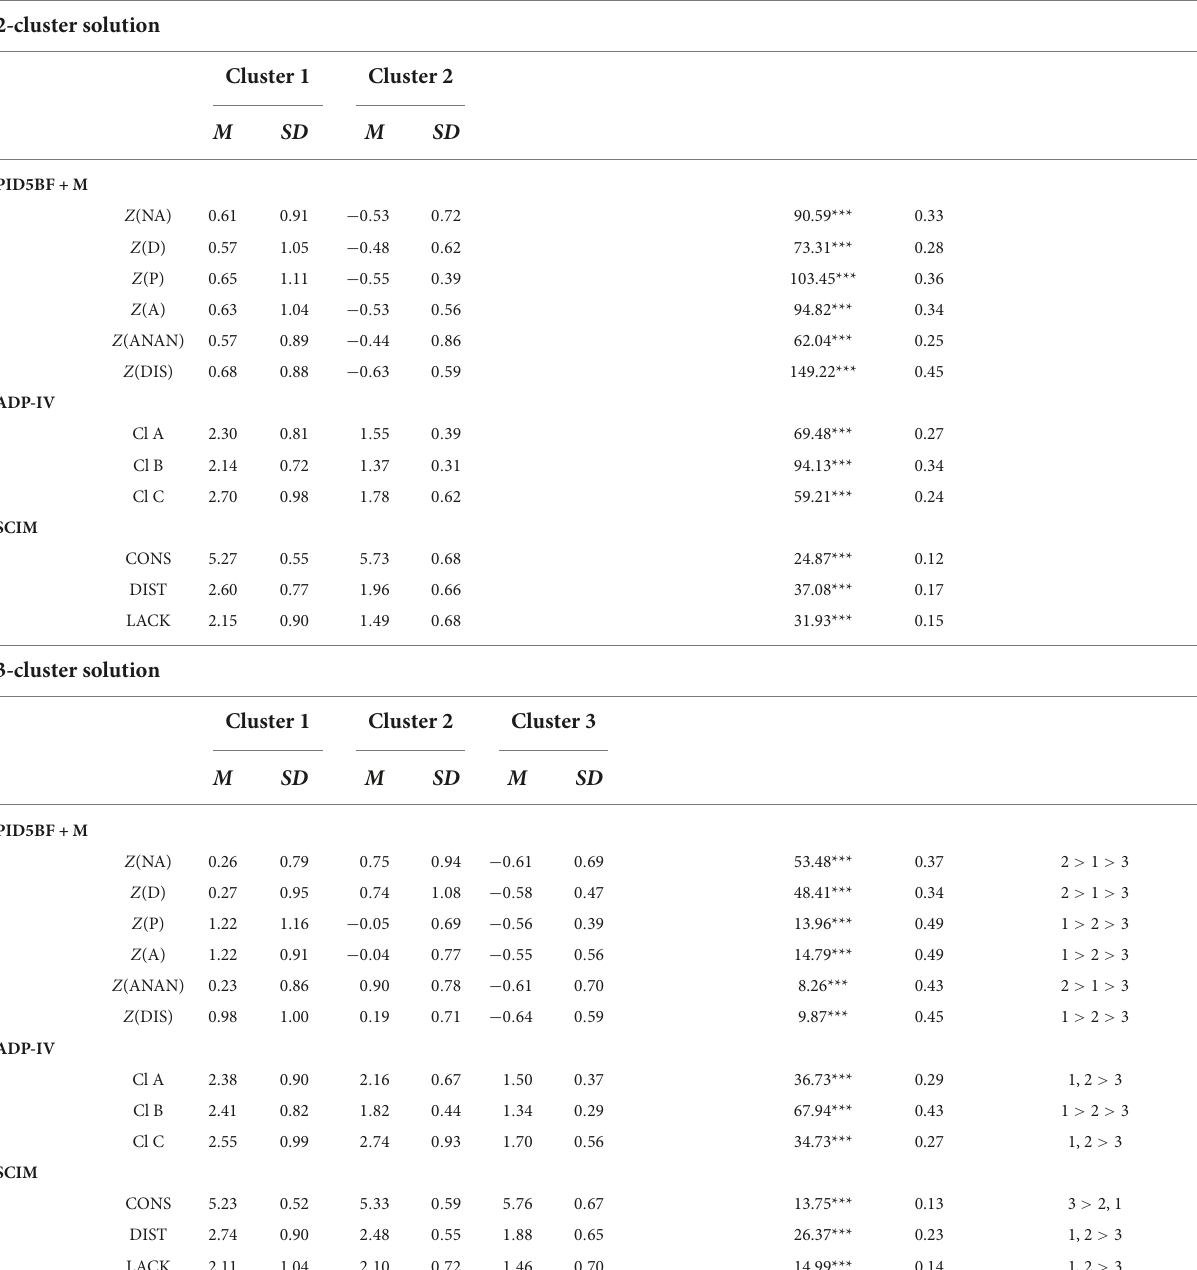
TABLE 2 PID5BF + M cluster solutions with PID5BF + M, ADP-IV, and SCIM means and standard